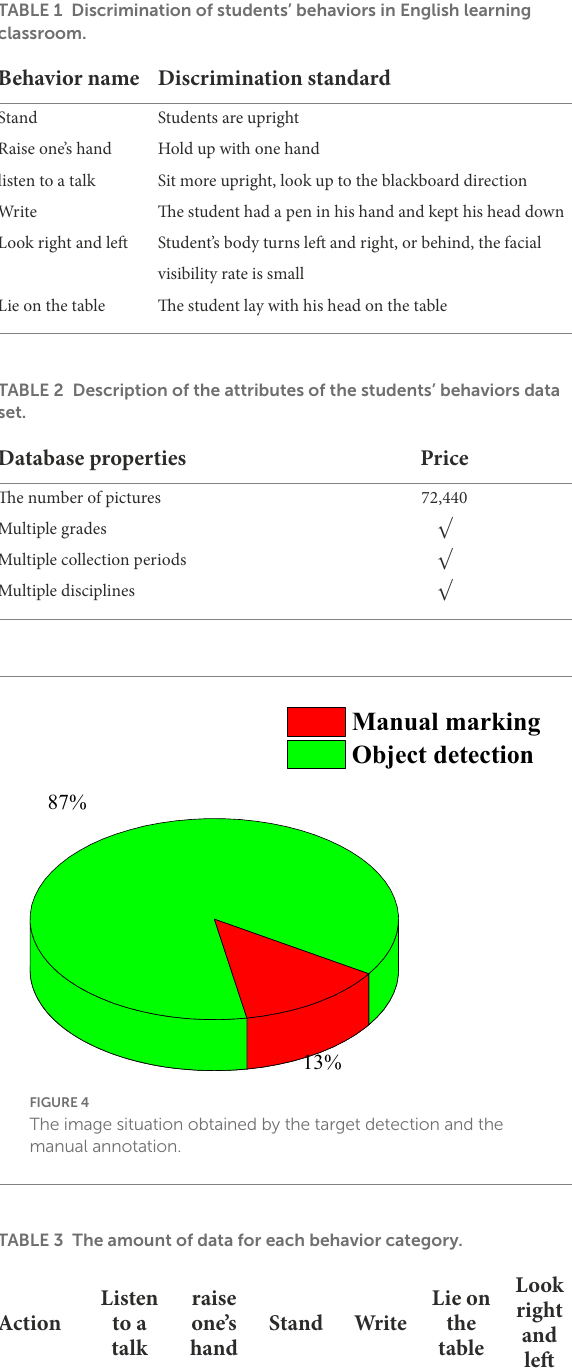
TABLE 1 Discrimination of students’ behaviors in English learning classroom.